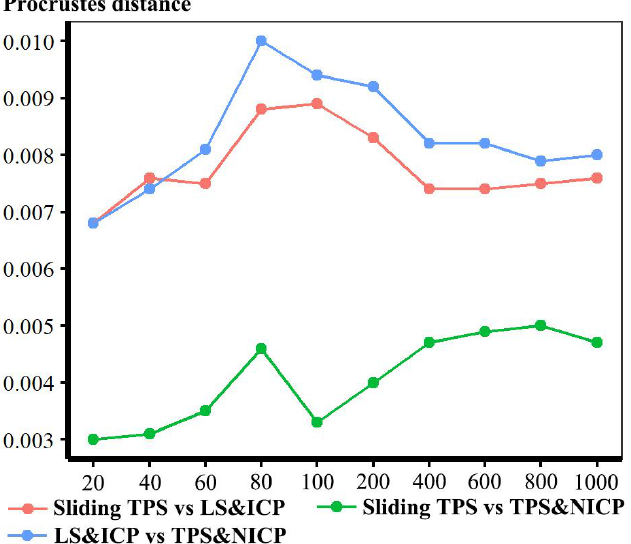
Figure 4. Procrustes distances computed between vertices of the mean surfaces of human heads generated by warping the template mesh to the semilandmarks obtained by different approaches.